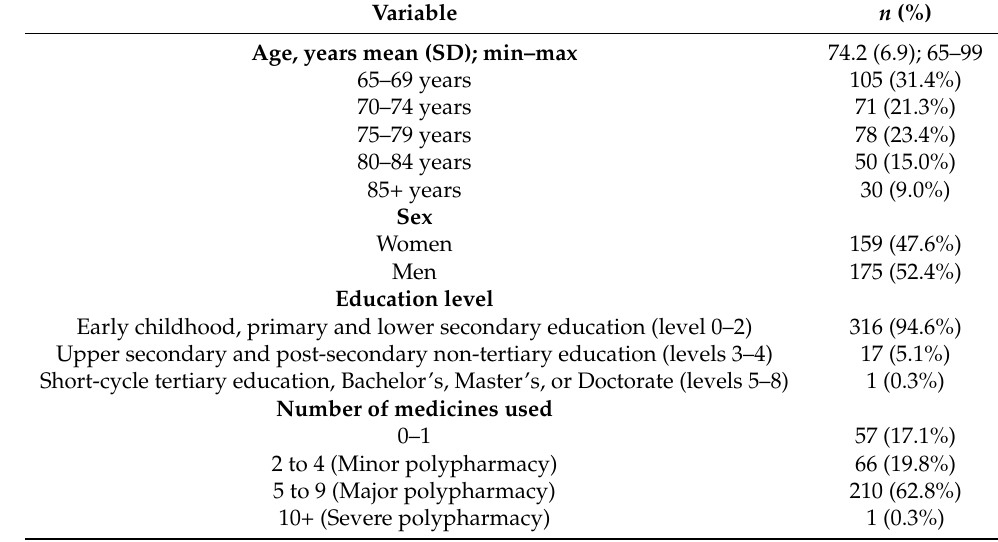
Table 1. Characteristics of patients ( n =